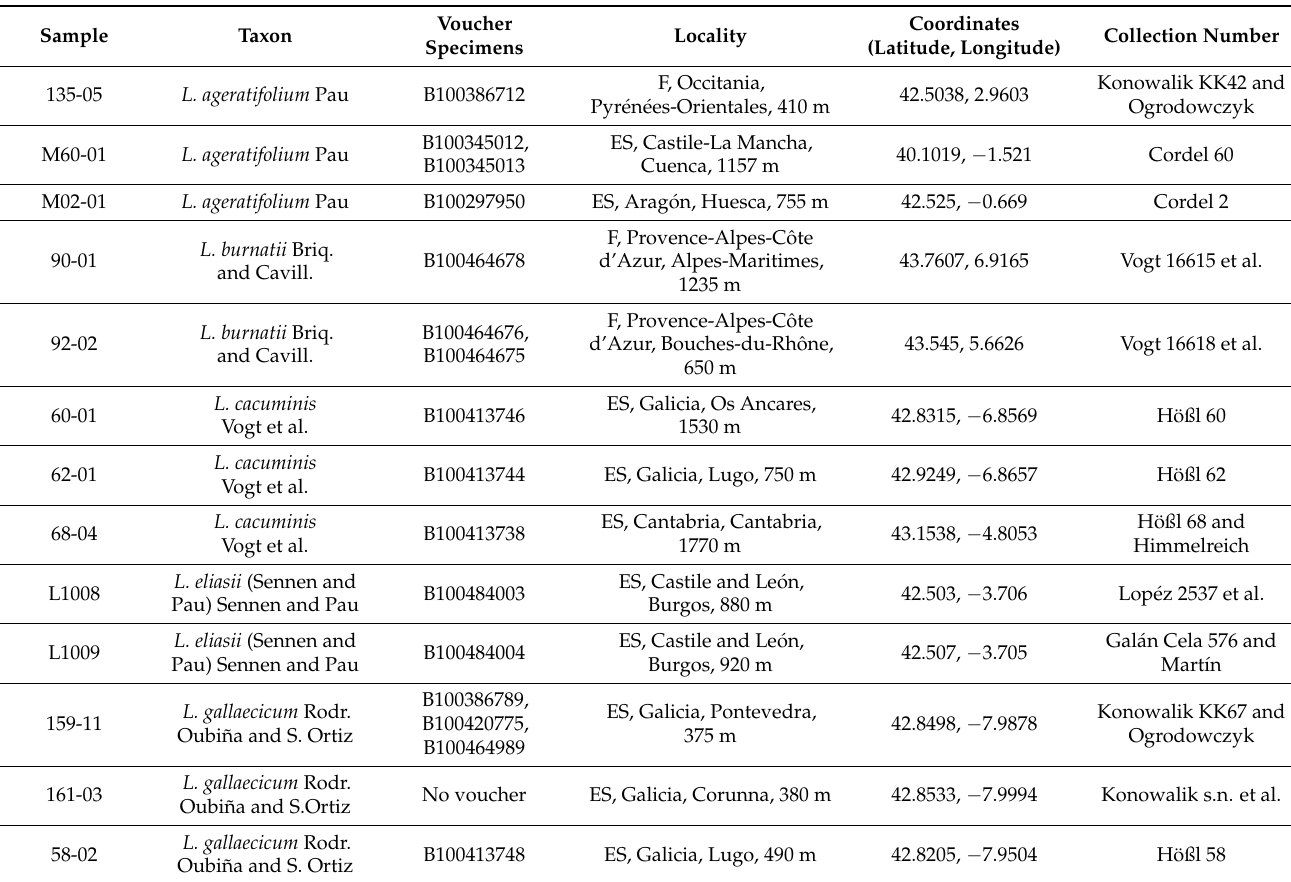
Table 2. List of samples used for the ddRAD analysis with information on voucher specimens (in B) and collection localities, coordinates, and